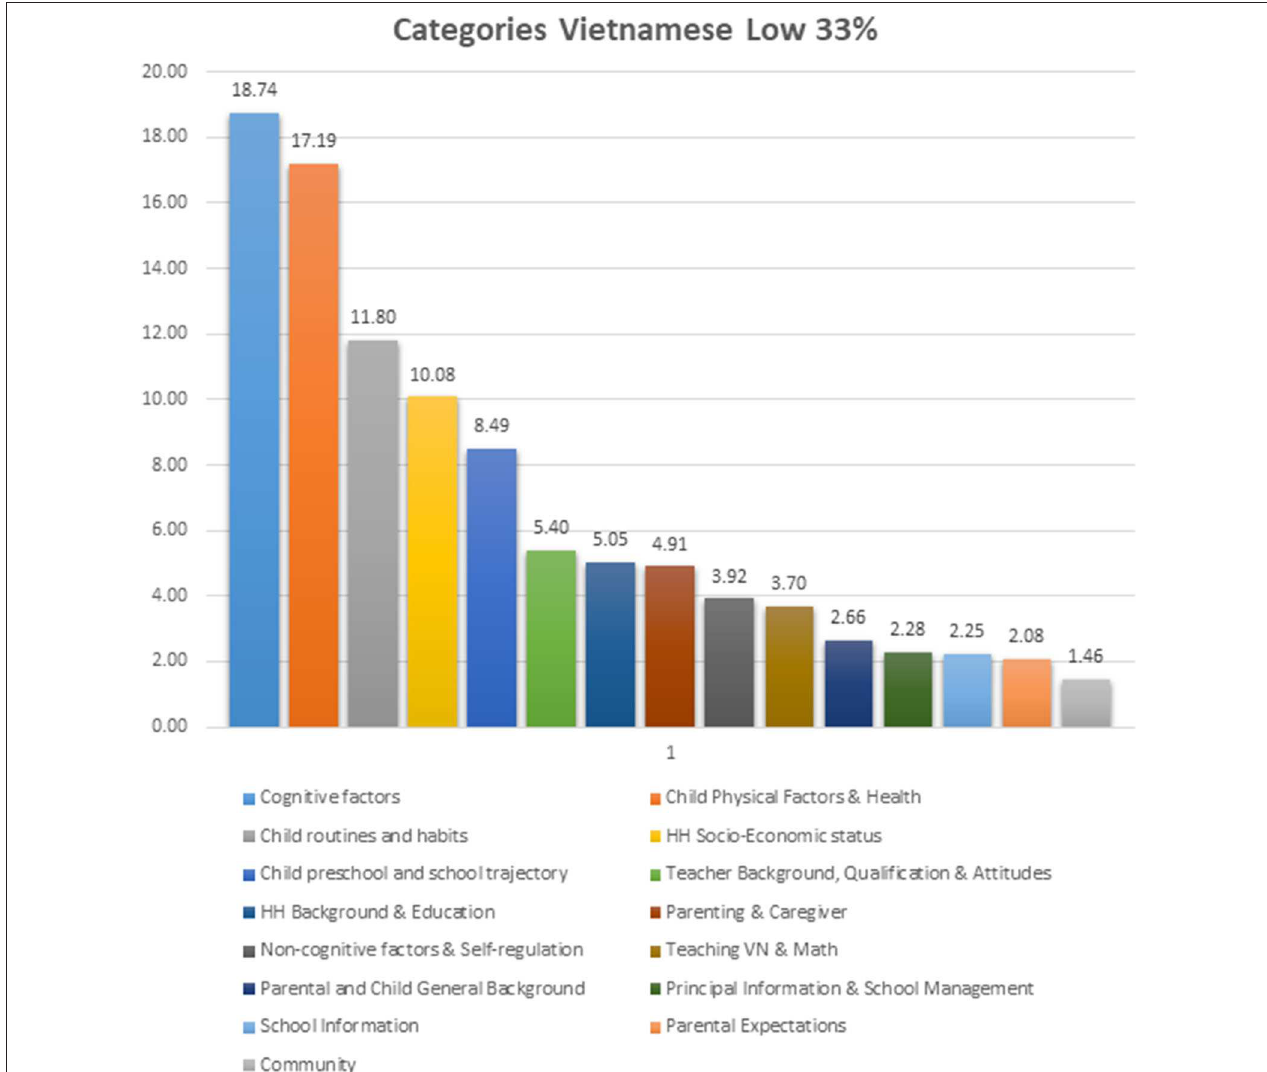
FIGURE 6 | Comparative observed predictive weight contribution for the low 33% of vietnamese performance by each of the categories of predictor